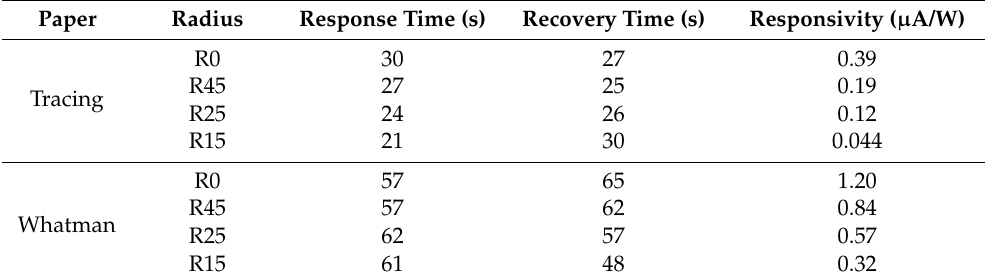
Table 2. UV Sensor parameters measured as a function of a curvature radius of 45, 25 and 15 cm.